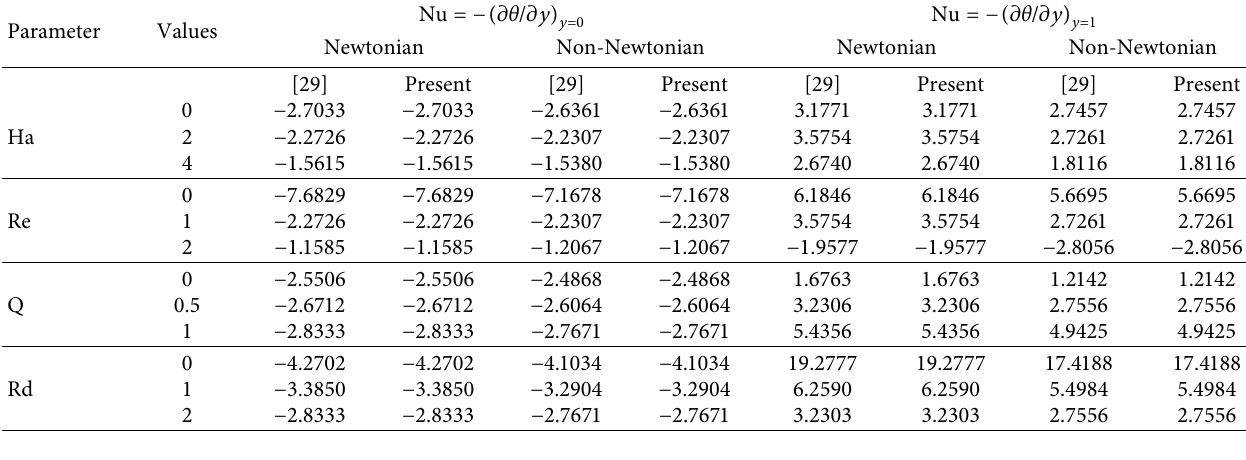
Table 1: Comparison of Nusselt number for Newtonian and non-Newtonian fluids with Srinivas et al. [29] for the limiting case of